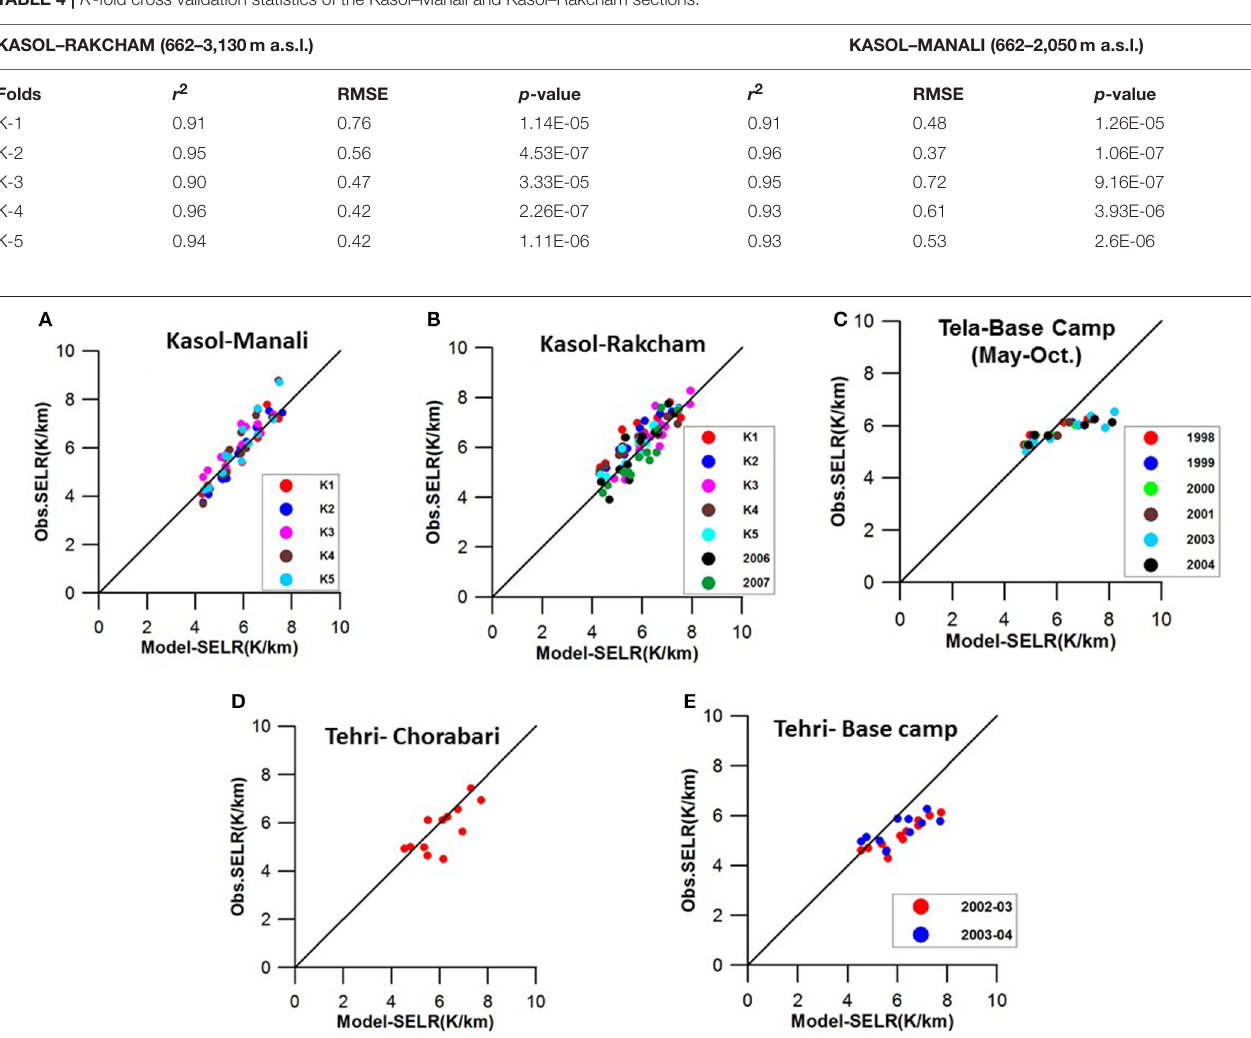
TABLE 4 | K -fold cross validation statistics of the Kasol–Manali and Kasol–Rakcham sections.